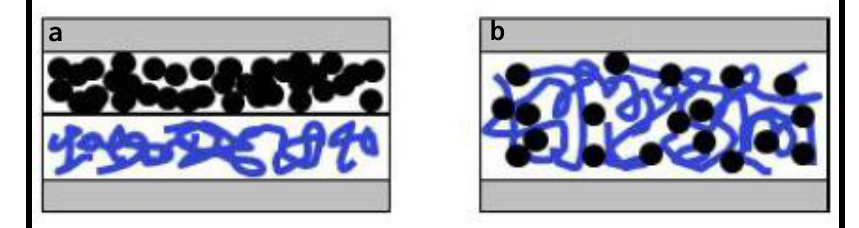
Fig.1: Schematics of examples of (a) bilayer and (b) BHJ blend